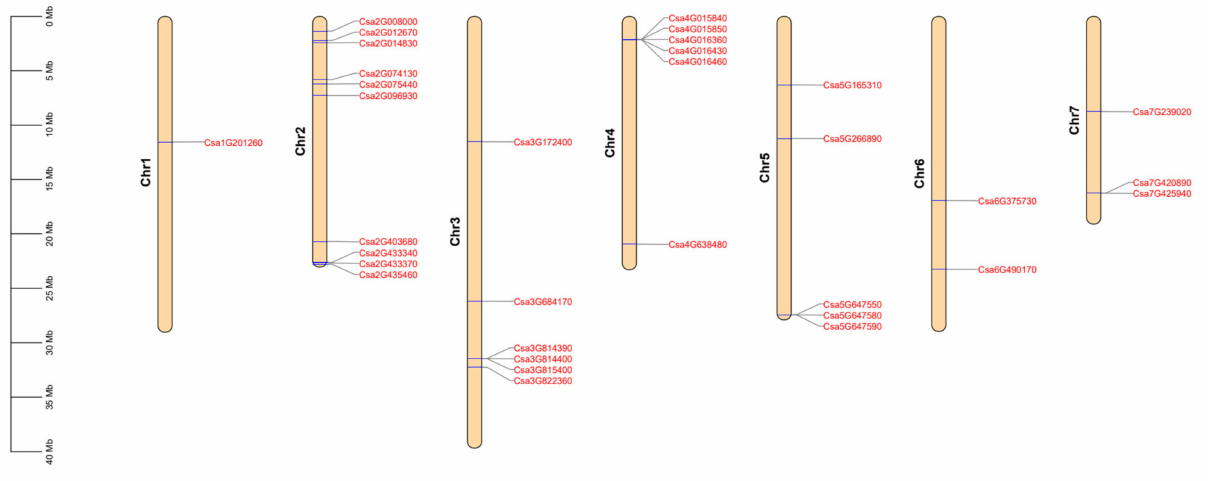
Figure 1. The distribution of the CNL genes located on the chromosomes in cucumber plants. The genetic distance of seven chromosomes were represented by the scale in megabases (Mb) on the left. The CNL genes are displayed using nomenclature for genome version 2 of Chinese Long cucumber. Blue lines represent the location of the gene on each